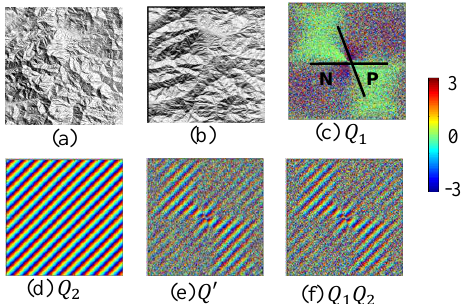
Figure 1. Impact of azimuth angle variation on Phase